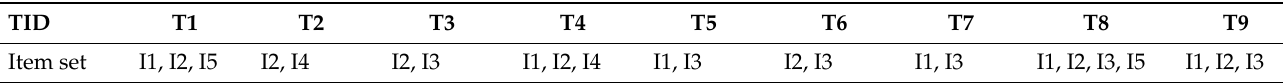
Table 3. Item transaction